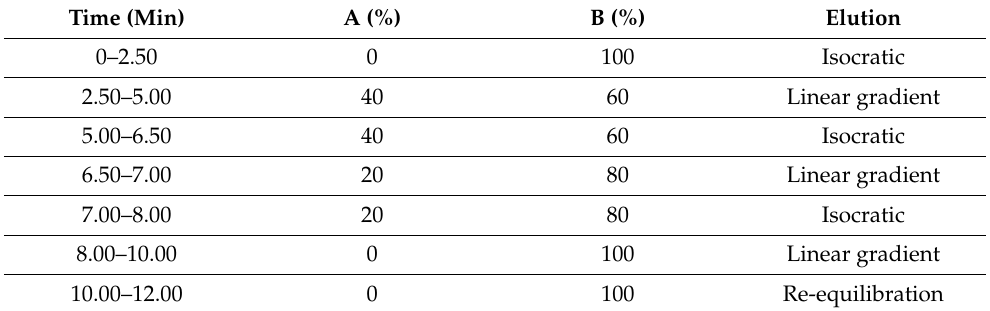
Table 5. Mobile phase gradient for the analysis of EMB, INH, PZA, and RFP in a UPLC-UV/MS system. Time (Min) A (%) B